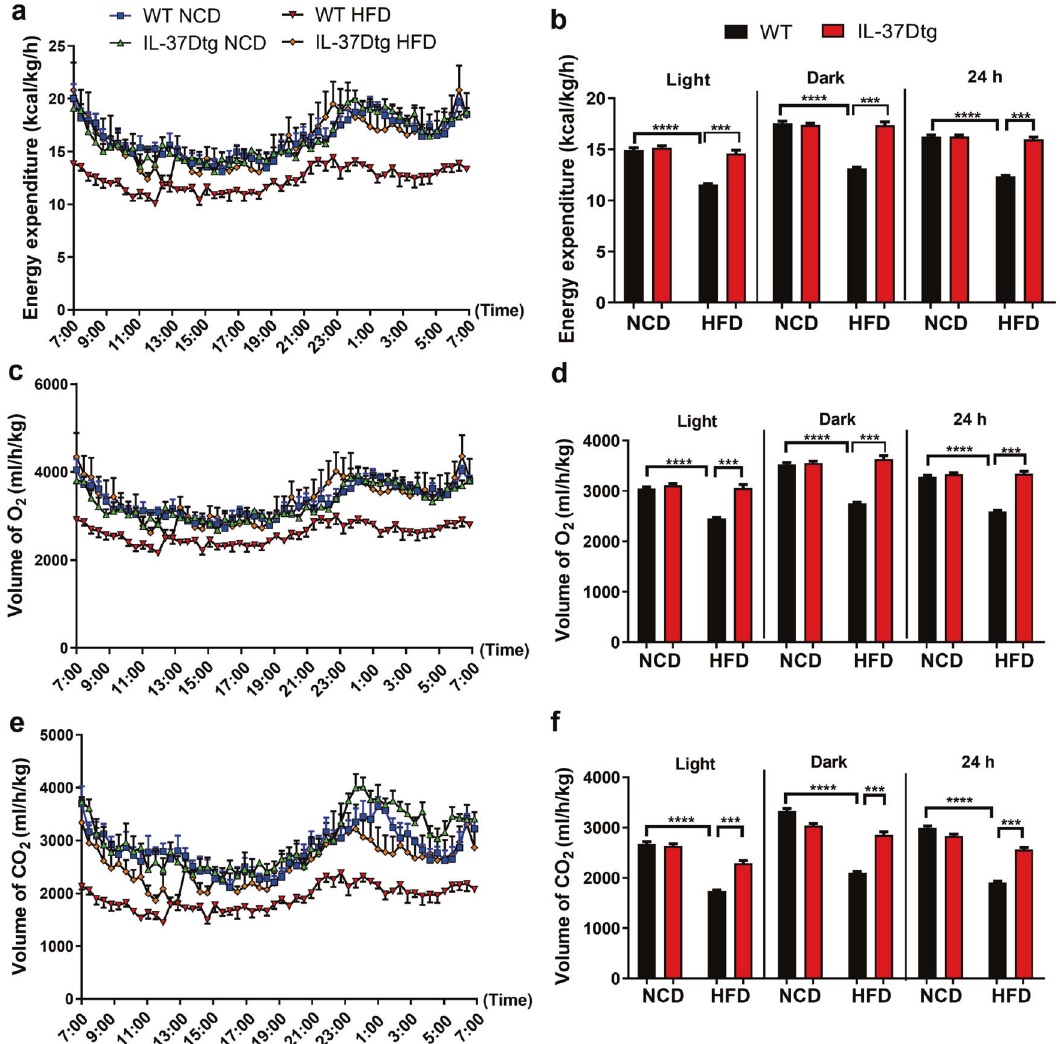
Fig. 2 IL-37D transgene increases energy expenditure in HFD-fed mice. Male IL-37Dtg and WT mice were fed on HFD or NCD ( n = 4 per group). The energy expenditure ( a , b ), VCO 2 ( c , d ), and VO 2 ( e , f ) were measured in individual mouse using calorimetry system. Data represent mean ± SEM. *** p < 0.001, determined by two-way ANOVA ( b , d , f